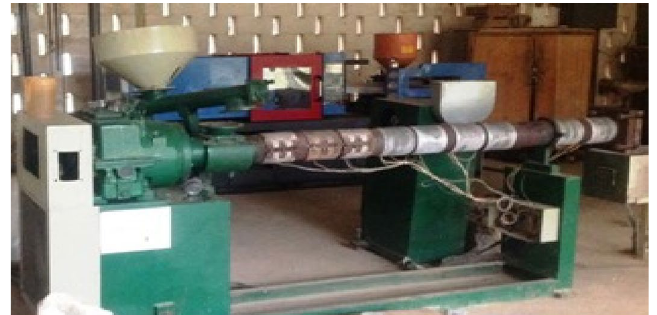
Figure 1. Single screw extruder.